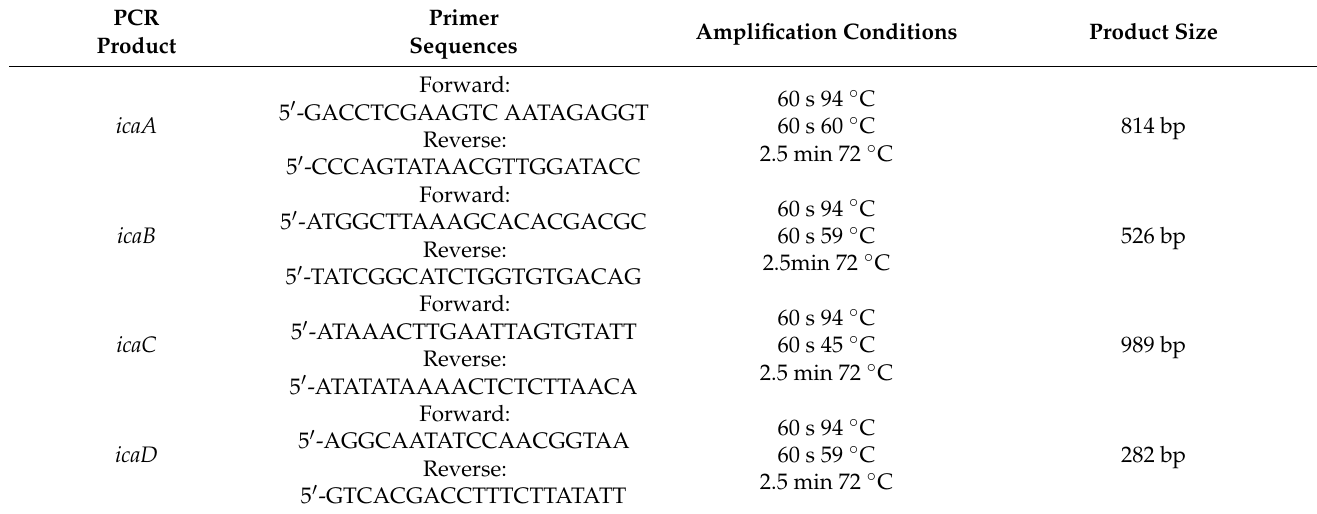
Table 3. Primer sequences, amplification conditions, and sizes of amplification products of icaABCD genes for Staphylococ- cus epidermidis.